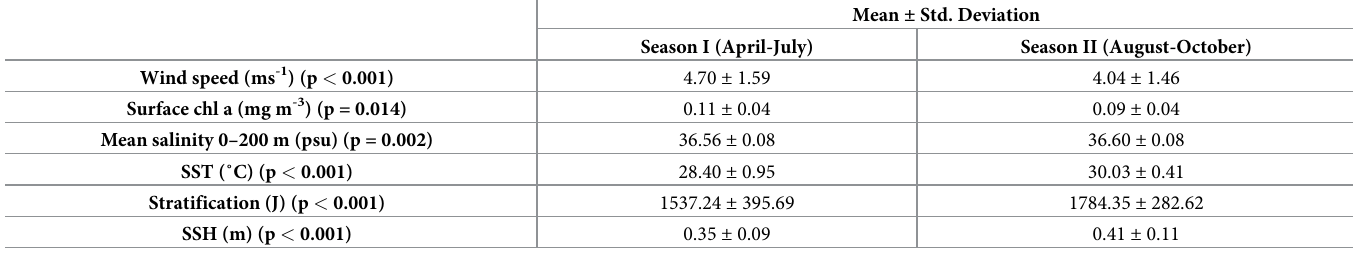
Table 4. Oceanographic variables comparison between seasons for cruises (6 per season) conducted between 2011 and 2018 in the deep-water region of the southern GoM.